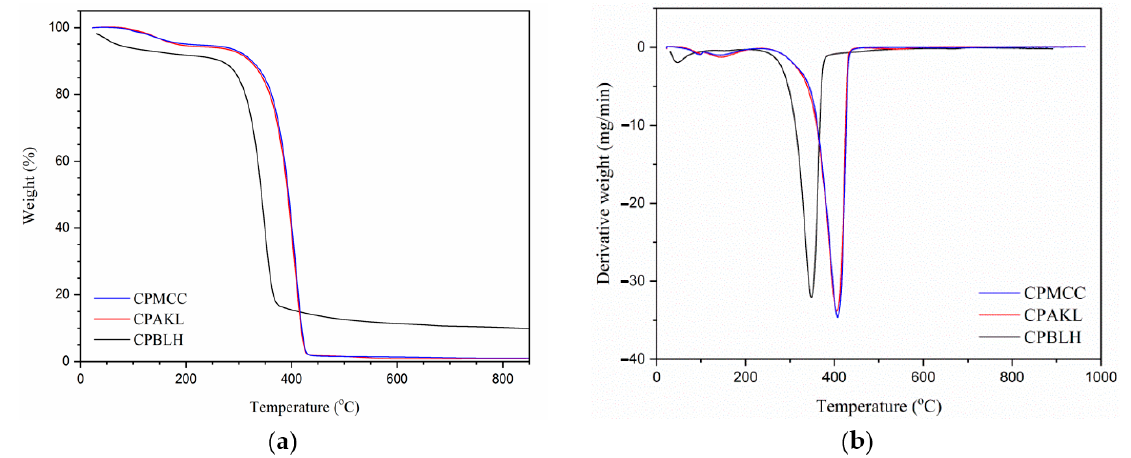
Figure 5. ( a ) TGA and ( b ) DTG curves of CPBLH, CPAKL, and CPMCC samples. Table 2. Thermal analysis data of CPBLH, CPAKL, and